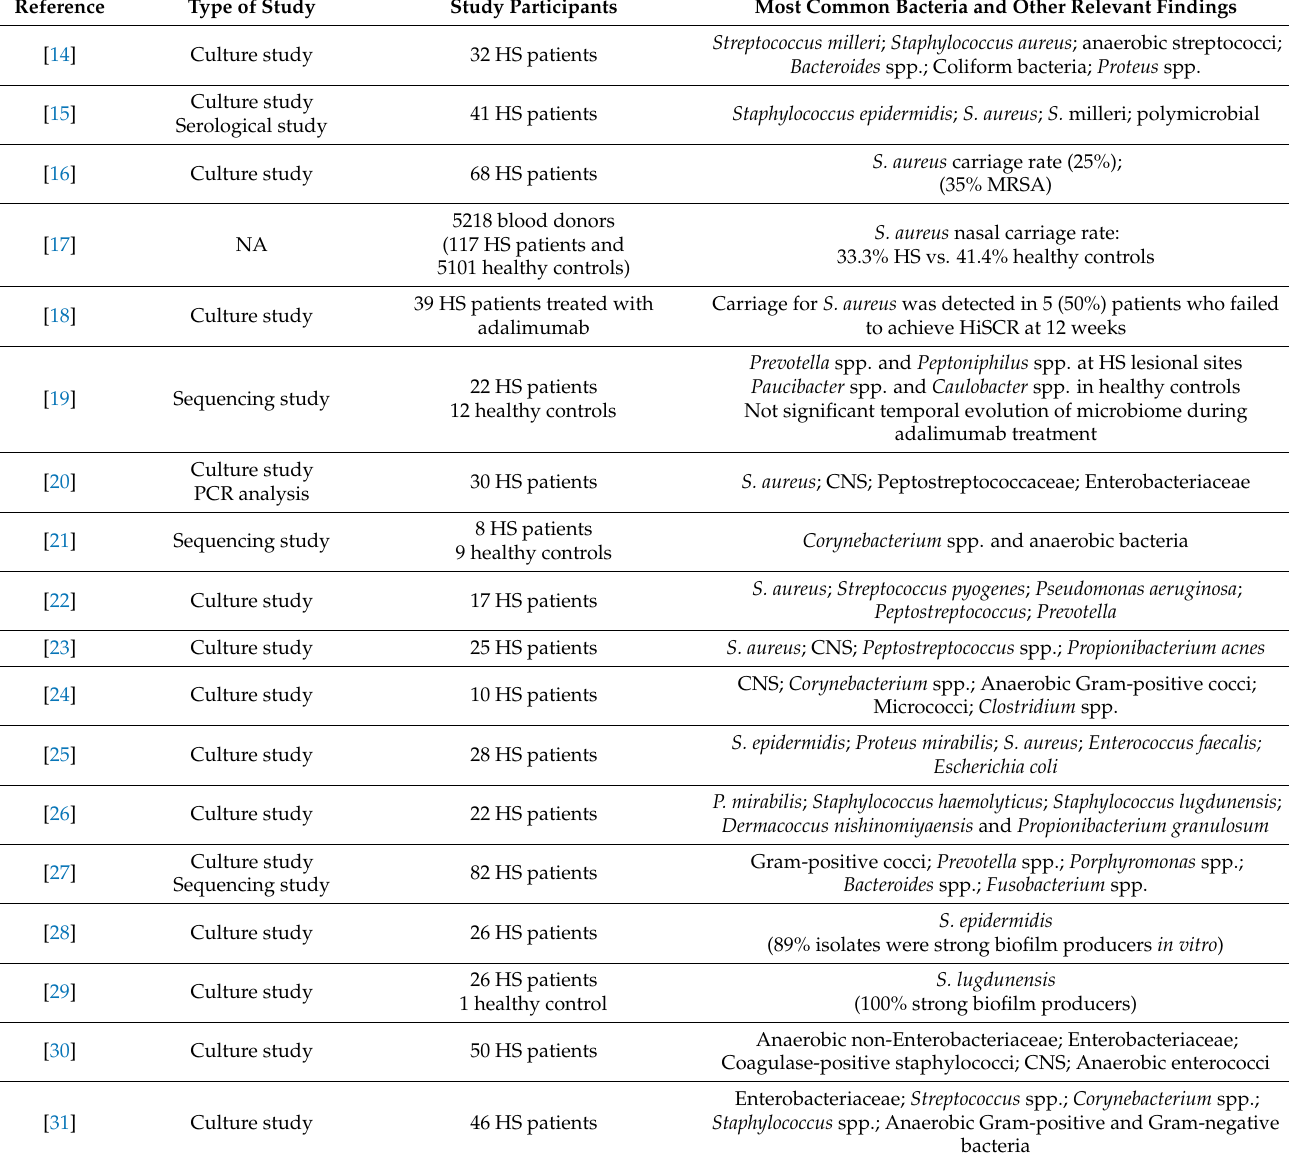
Table 1. A summary of studies focusing on bacteria in